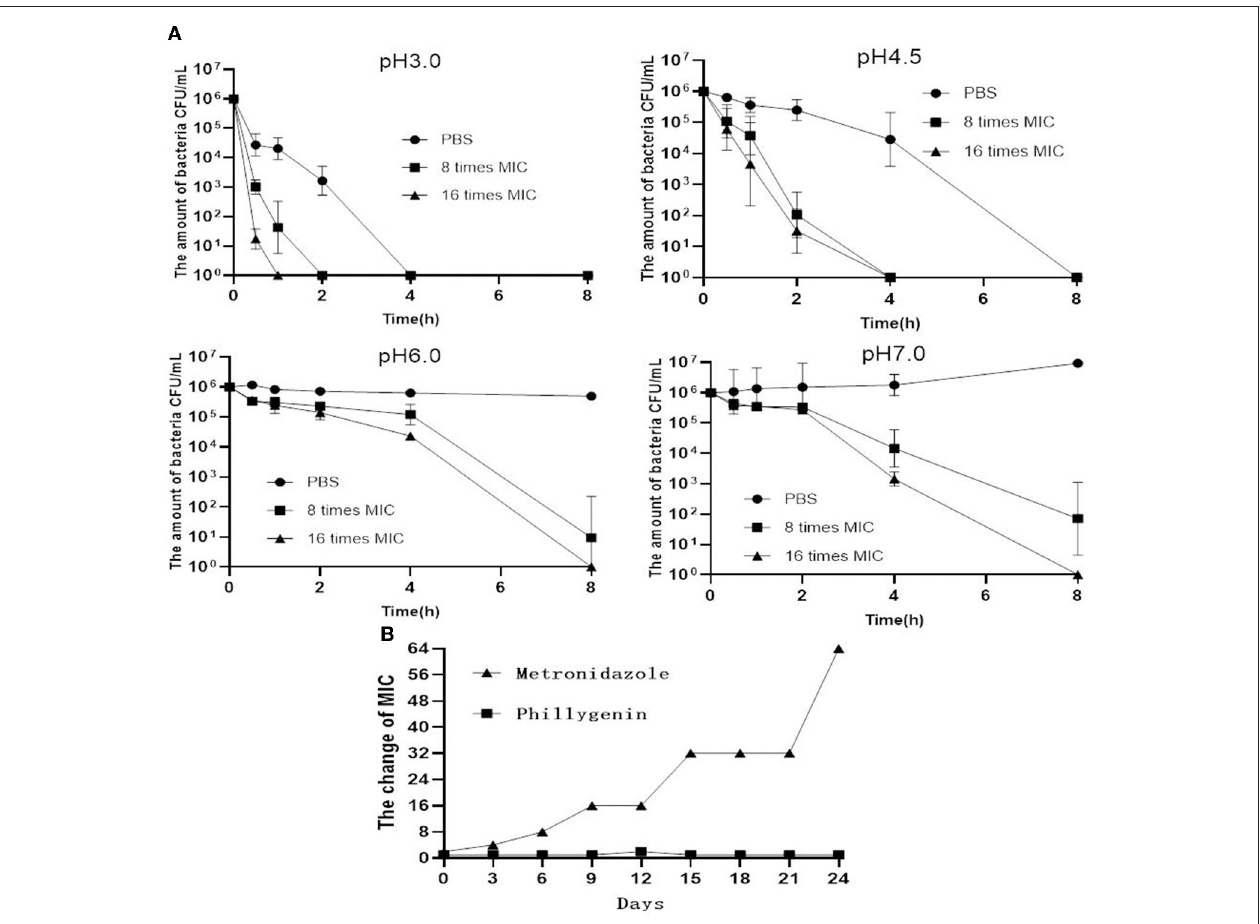
FIGURE 5 | Acid response and drug resistance induction of phillygenin. (A) The detection of MBCs of phillygenin ( µ g/ml) against H. pylori at different pHs and (B) the detection of inducing drug-resistant H. pylori to phillygenin.